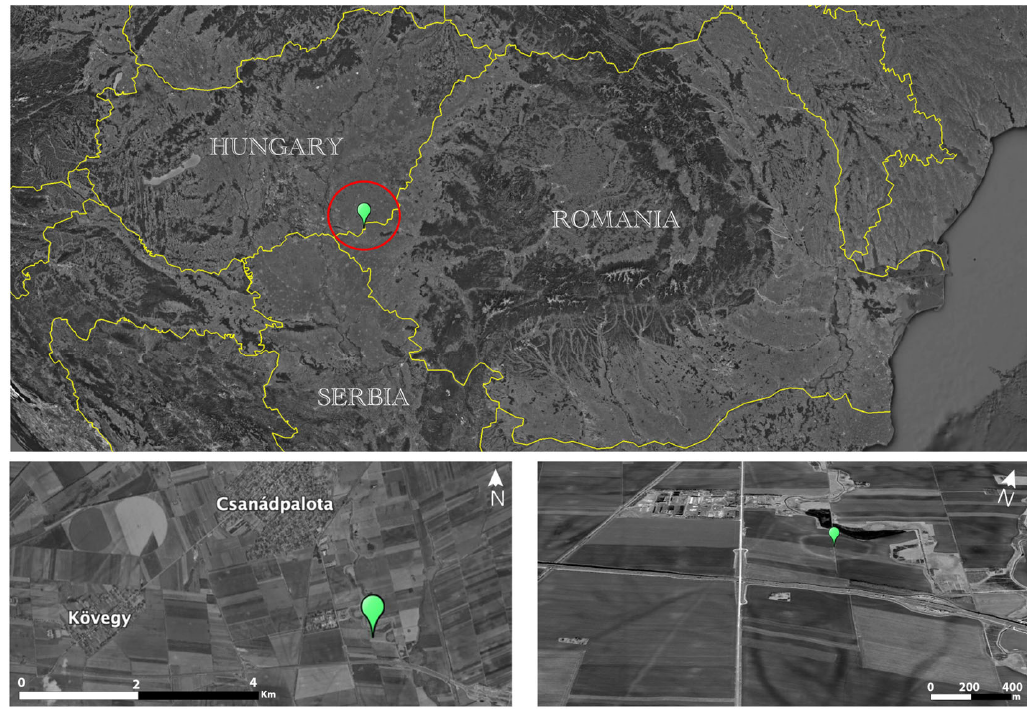
Figure 1. Location of Csanádpalota ‐ Juhász T. tanya (Google Earth Image—edited).